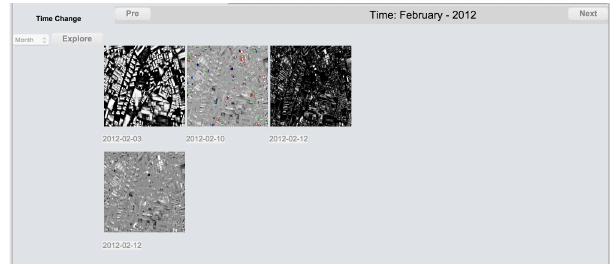
Figure 9. Temporal series information year 2012